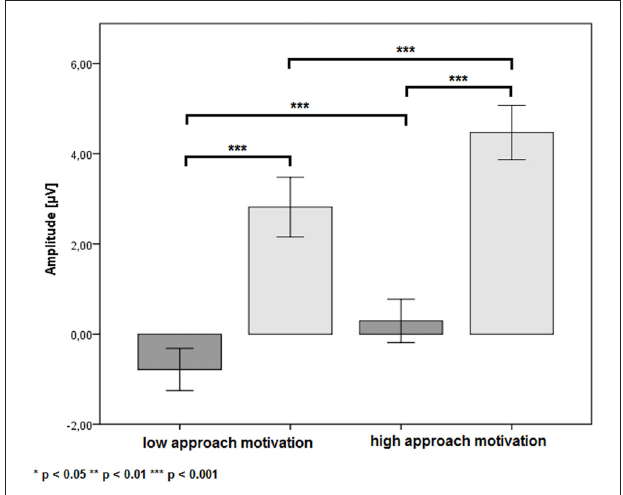
FIGURE 3 | The P3b amplitude as a function of APPROACH MOTIVATION × CUES. Error bars represent one standard error of the